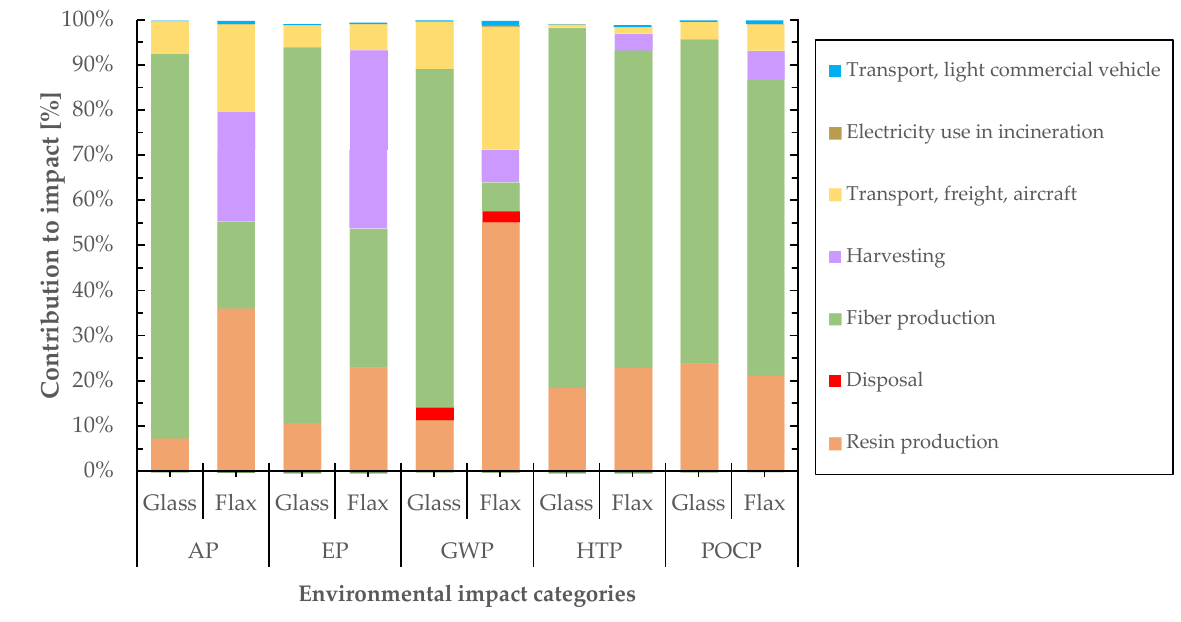
Figure 8. Contribution analysis for the impact categories for the plain weave glass and flax 200 wet variants.